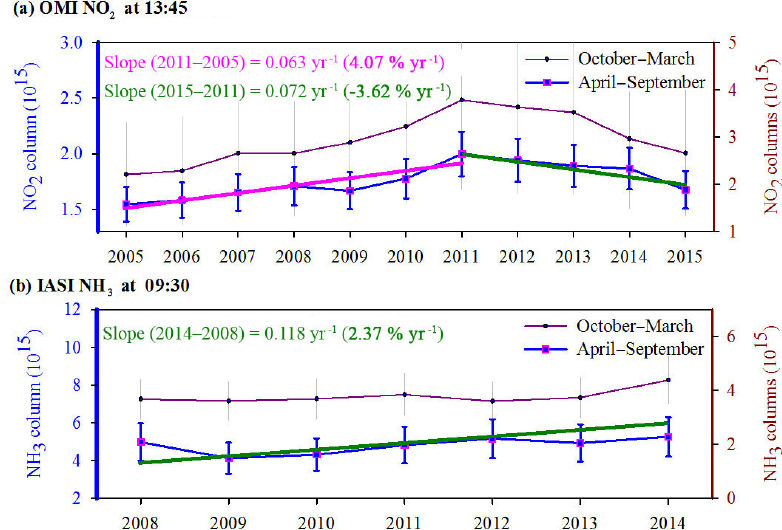
Figure 3. Time series of average OMI NO 2 and IASI NH 3 columns over China during warm months (April–September) and cold months (October–March). The time period of NO 2 columns was from 2005 to 2015, while the time span of NH 3 columns was from 2008 to 2014 over China. The associated mean error for each period is presented here as error bars. The percent increase or decrease rate (%) was the + Y 3 − Y 2 + ... + Y n + 1 − Y n ) × 1 long-term mean, calculated as 100 × ( Y 2 − Y 1 . n Y 1 Y 2 Y n